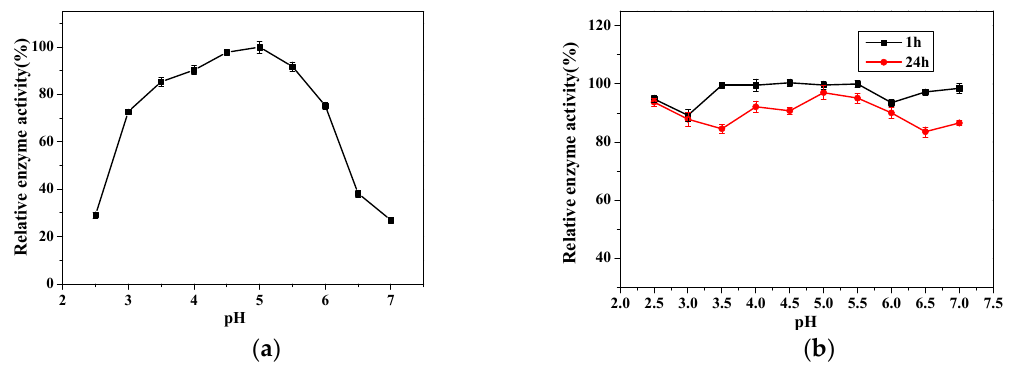
Figure 4. Relative enzymatic activity of the dextranase as a function of pH ( a ) and as a function of pH for 1 h and 24 h ( b ).